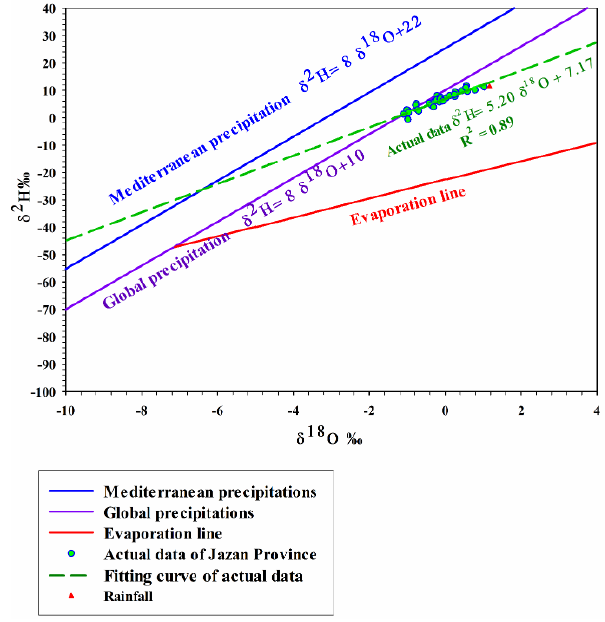
Figure 4. Relationship between δ 18 O ‰ and δ 2 H‰.